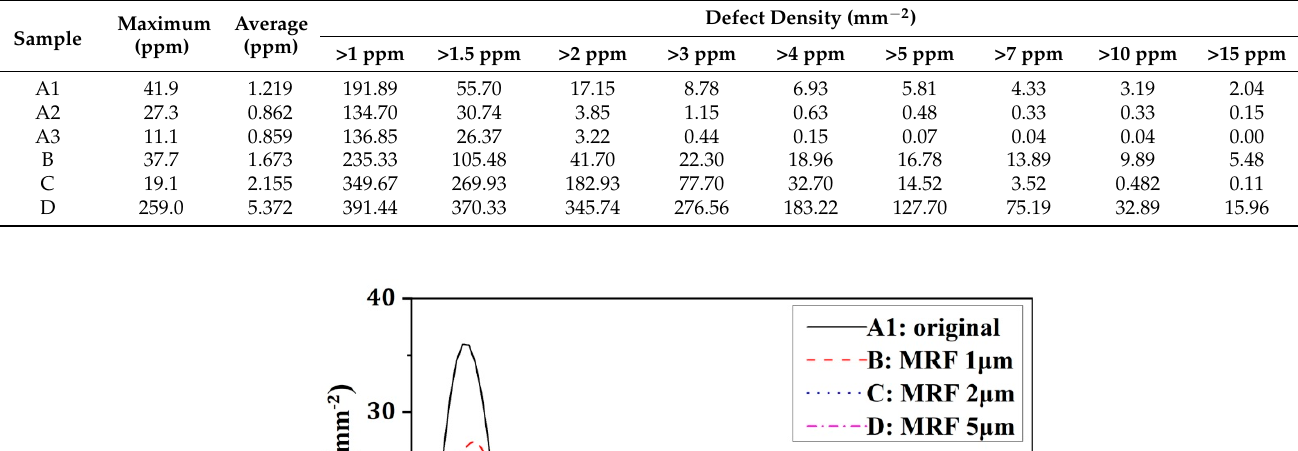
Table 2. Photothermal absorption statistic results including characteristic absorption and defect density with different absorption levels.